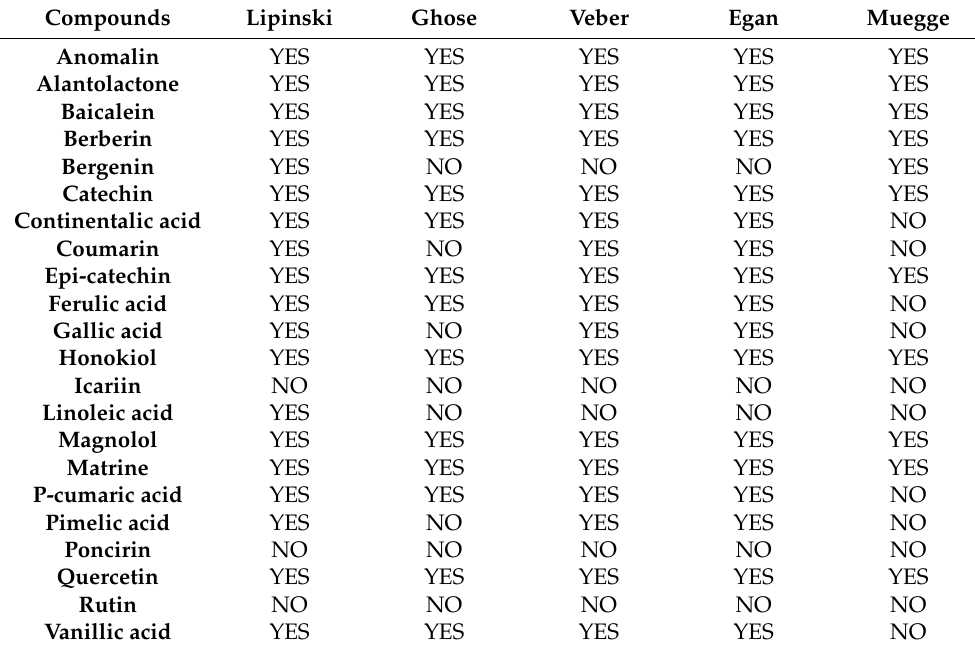
Table 4. The drug-likeness behavior of the selected compounds using computational